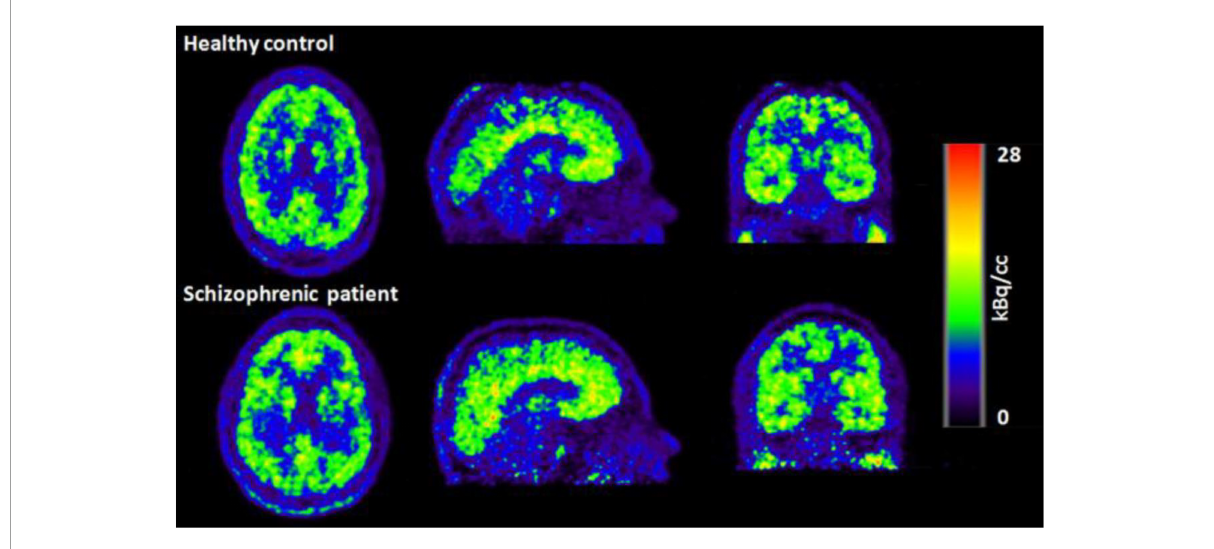
FIGURE12 PET images of the healthy control (top row) and schizophrenic patient (bottom row) acquired during the first resting state measurement (Neuner et al., 2019).